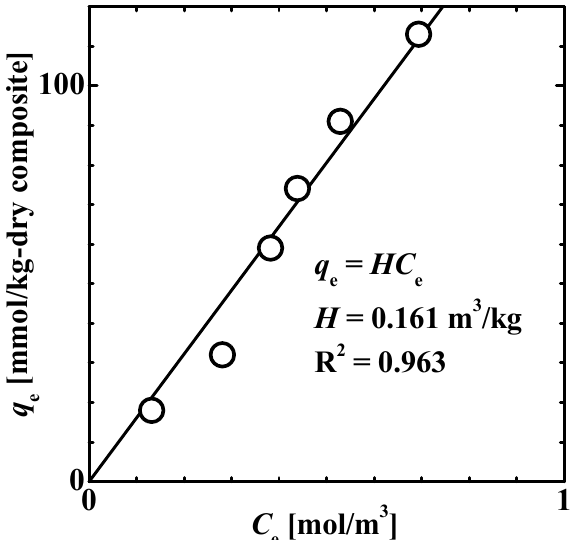
Figure 2. Amount of 4-isopropylphenol adsorbed onto the TiO 2 nanoparticle-loaded fiber as a func- tion of temperature.